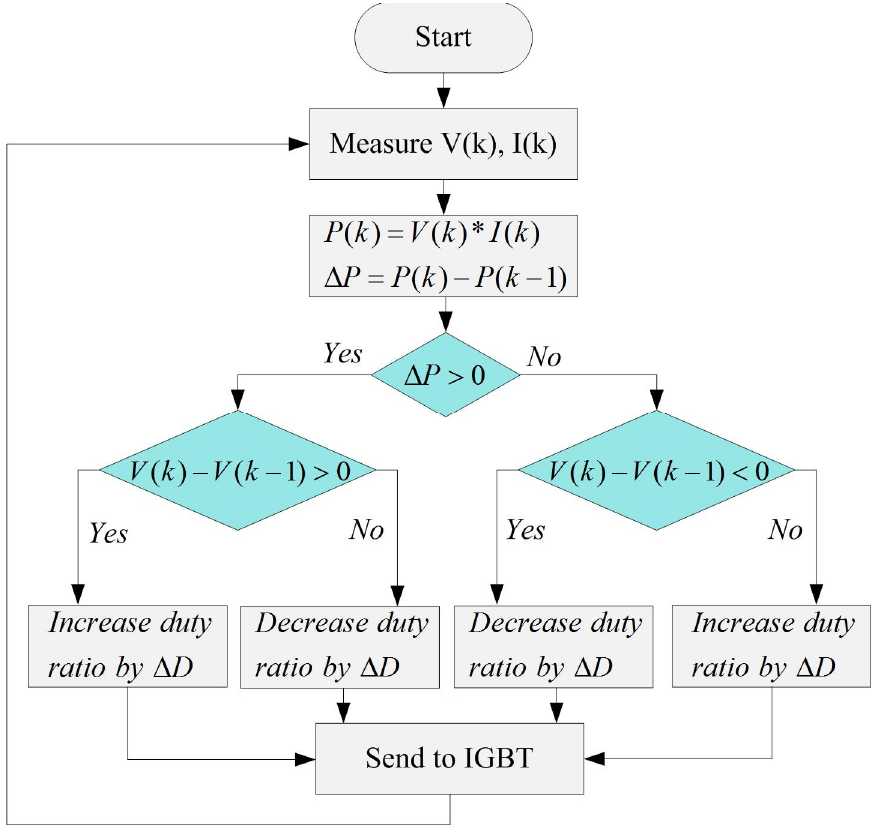
Figure 1. Flowchart of P-&-O based MPPT Algorithm.